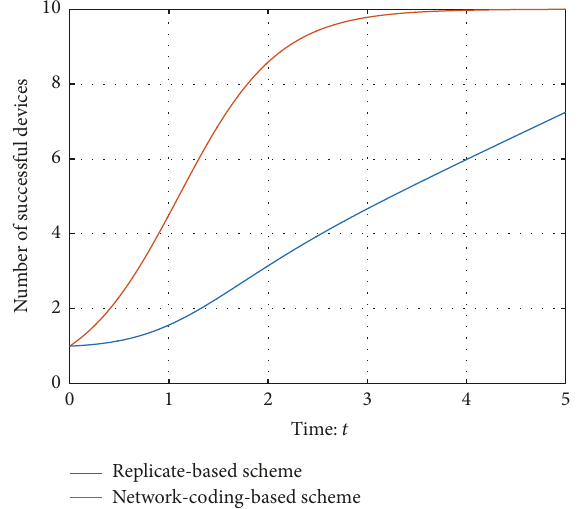
Figure 4: Performance of network-coding-based scheme and rep- licate-based scheme.